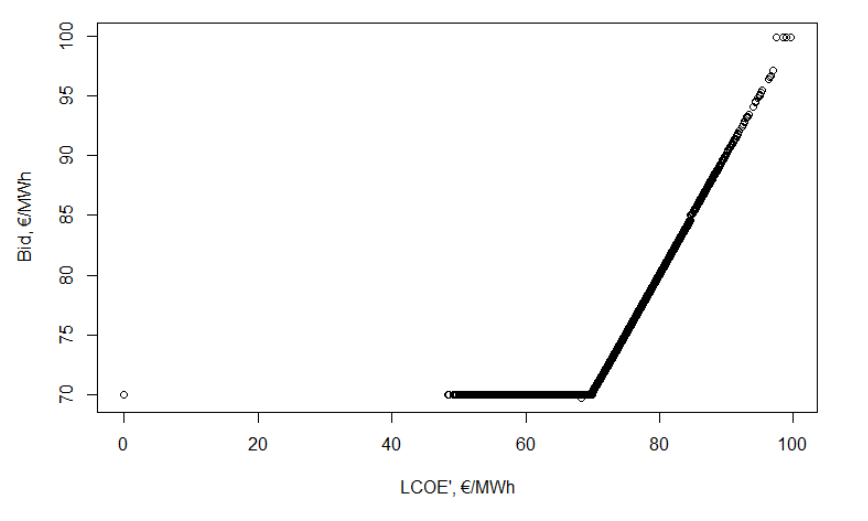
Figure 9. The optimal bid function assuming F 4 bid distribution, source: own